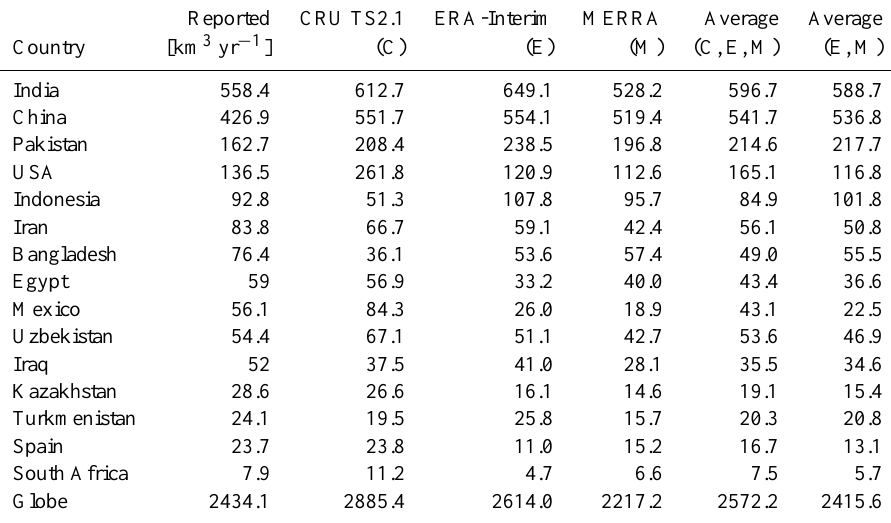
Table 3. Comparison of simulated IWR to reported statistics [km 3 yr − 1 ] for major irrigated countries of the world for the year 2000 ( N = 212). IWR was simulated with the CRU TS2.1 (C), ERA-Interim (E) and MERRA (M) climate respectively. Reported statistics was obtained from the FAO AQUASTAT database (http://www.fao.org/nr/water/aquastat/main/index.stm). Simulated IWR with the CRU TS2.1 climate is provided for a reference and is not included in our overall analysis.